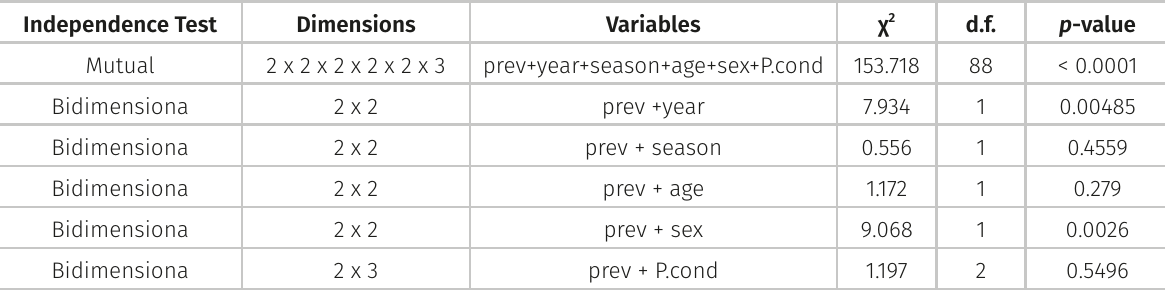
Table II. Contingency table with independence tests for the prevalence of fleas plus five explanatory variables in Zaedyus pichiy from Mendoza, Argentina. Prev= prevalence; P.cond= Physical condition. Independence Test